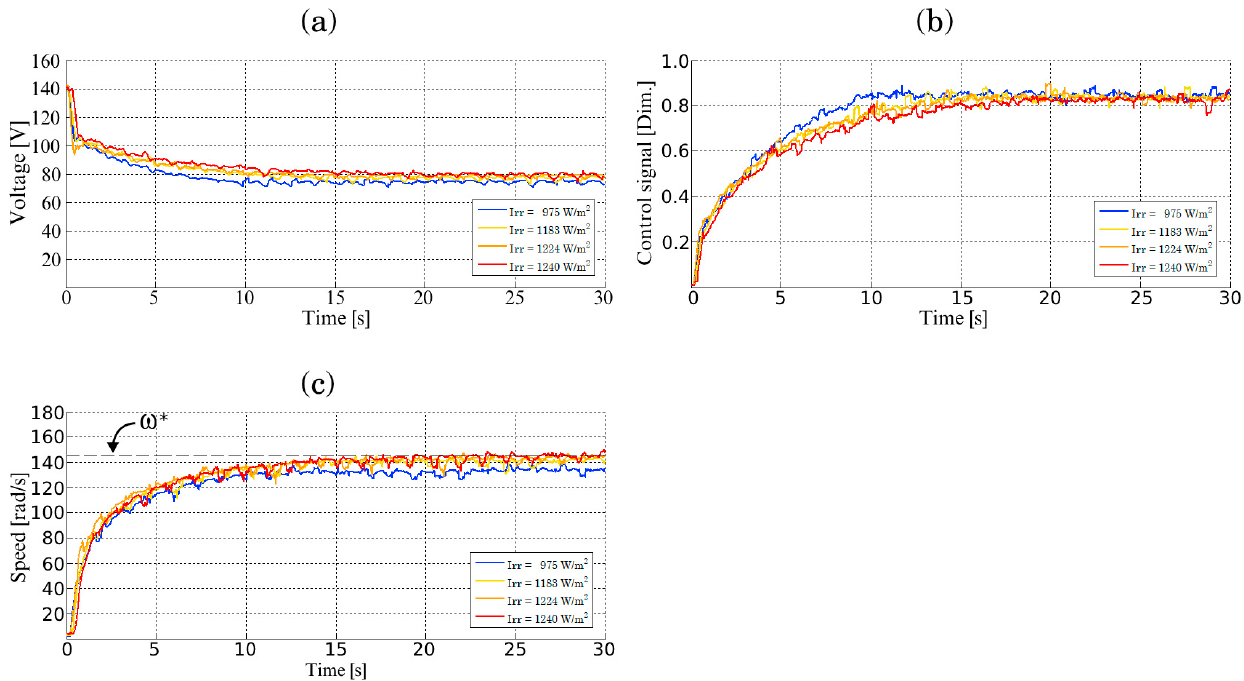
Figure 24. Irradiance variation effects in: ( a ) DC motor input voltage, ( b ) ADRC signal control, and ( c ) DC motor speed.